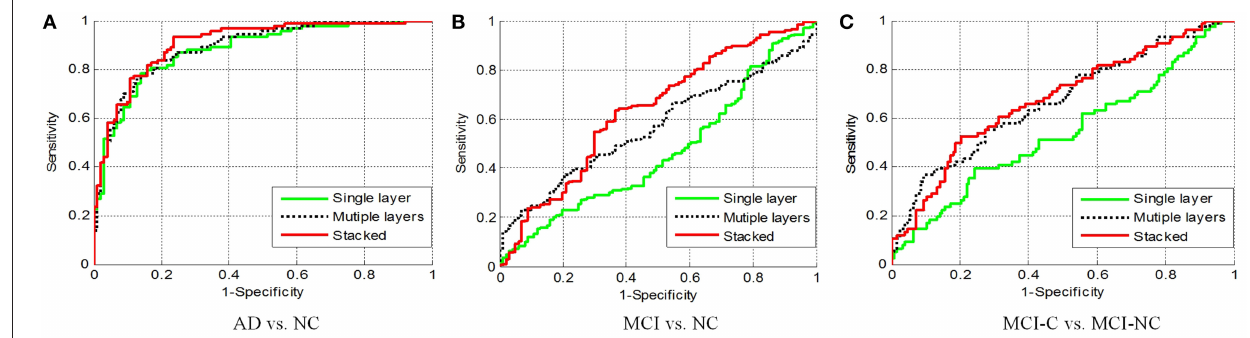
FIGURE 8 | RoC results with different layers. (A) AD vs. NC; (B) MCI vs. NC; (C) MCI-C vs.